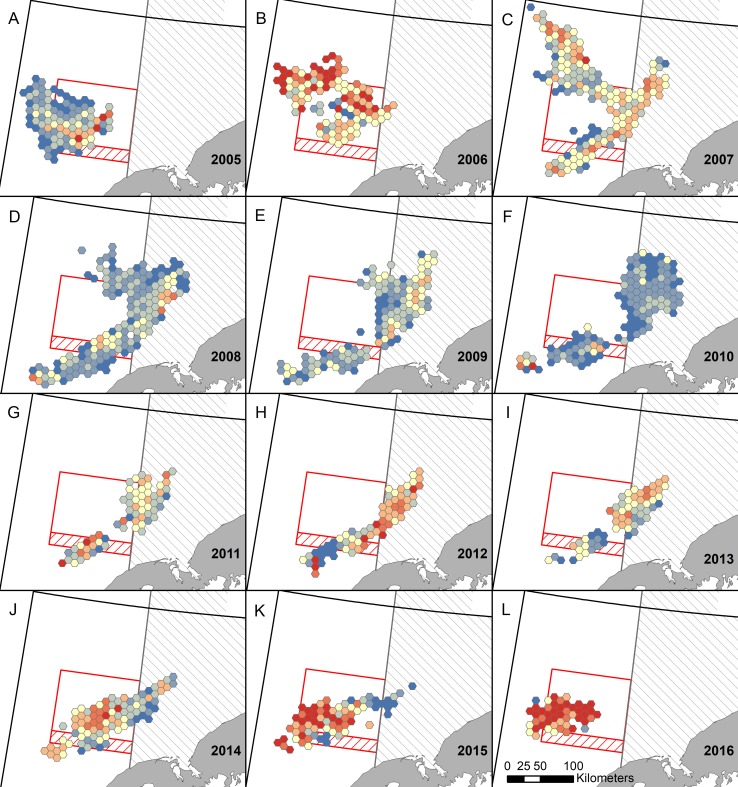
Spatial and temporal distribution of mean catch per unit effort (CPUE).Hexagonal grid cells (100 km2) show the mean CPUE of Bristol Bay red king crab using data from daily fishing logs (dark red ≥ 40, medium red = 35–39.9 light red = 30–34.9, cream = 25–29.9, light blue = 20–24.9, medium blue = 15–19.9, and dark blue < 15 mean crab per pot). Only grid cells represented by ≥ 3 vessels are included due to confidentiality restrictions. Areas with restrictions on trawling are outlined in red or gray and are described in Fig 1.